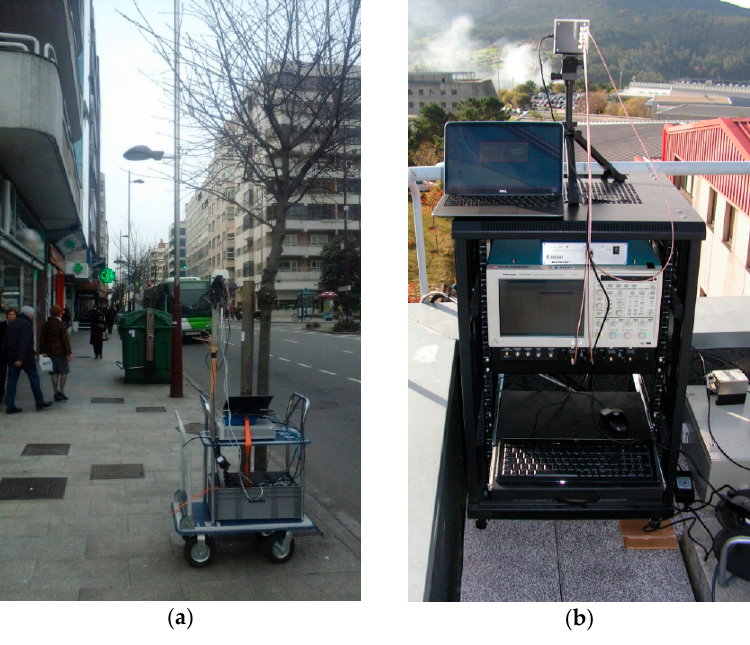
Figure 1. Pictures of the ( a ) Tx and ( b ) Rx.